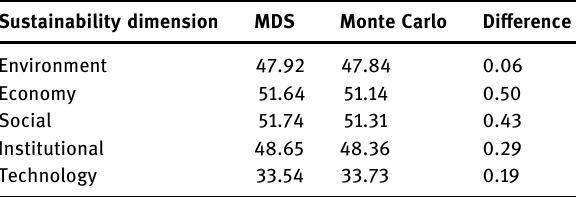
Table 3: Di ff erences in the sustainability index value of RAP - DEFARMPO and Monte Carlo